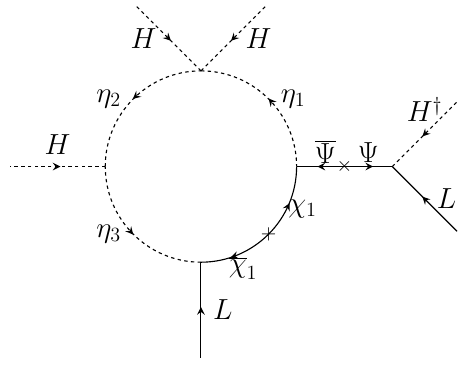
Figure 10 . The most minimal model that one can construct at 1-loop d = 7 order with no SU(2) L representations larger than triplet. The model is generated from the diagram T11-i in (cid:12)gure